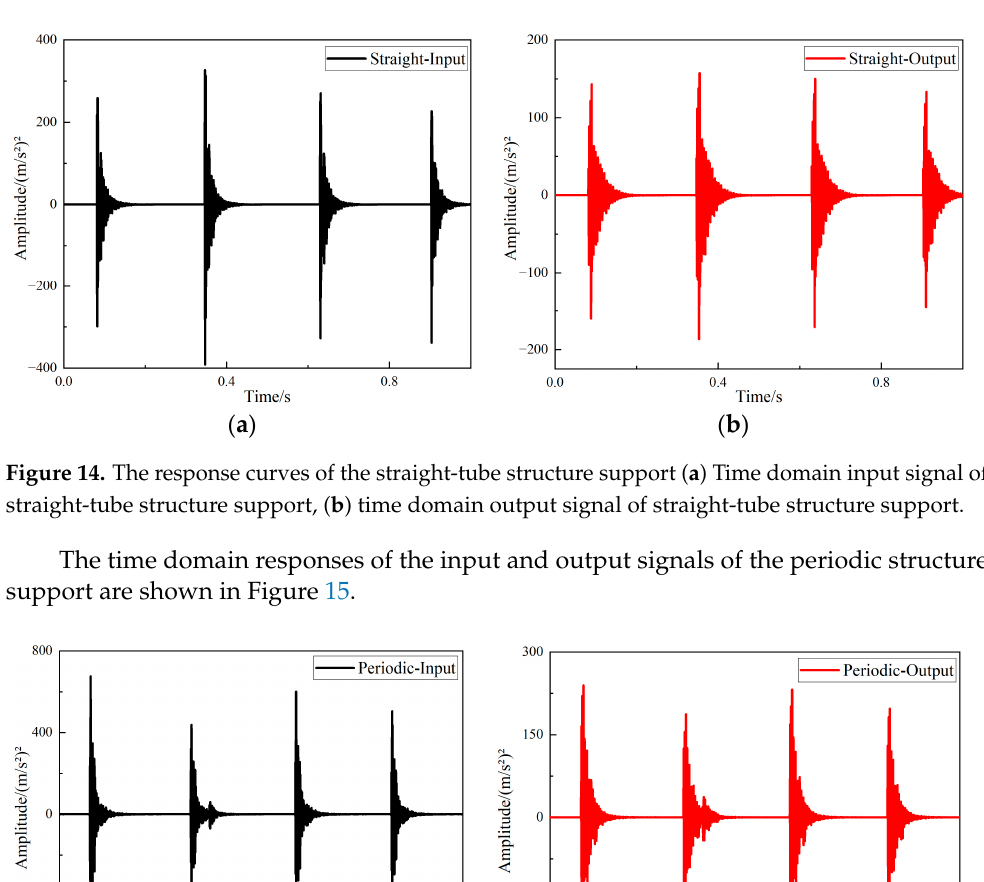
Figure 13. Simulation results of periodic structural support. ( a ) Load-displacement curve of periodic structure support, ( b ) simulation FRF value curve of periodic structure support.